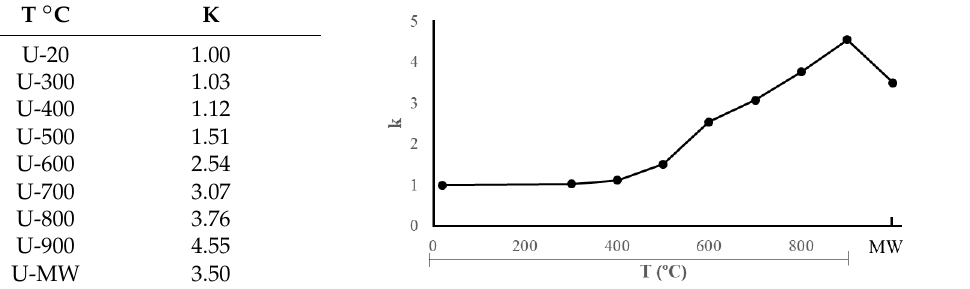
Table 2. The expansibility k and its evolution with the temperature of the studied samples. T ◦ C K